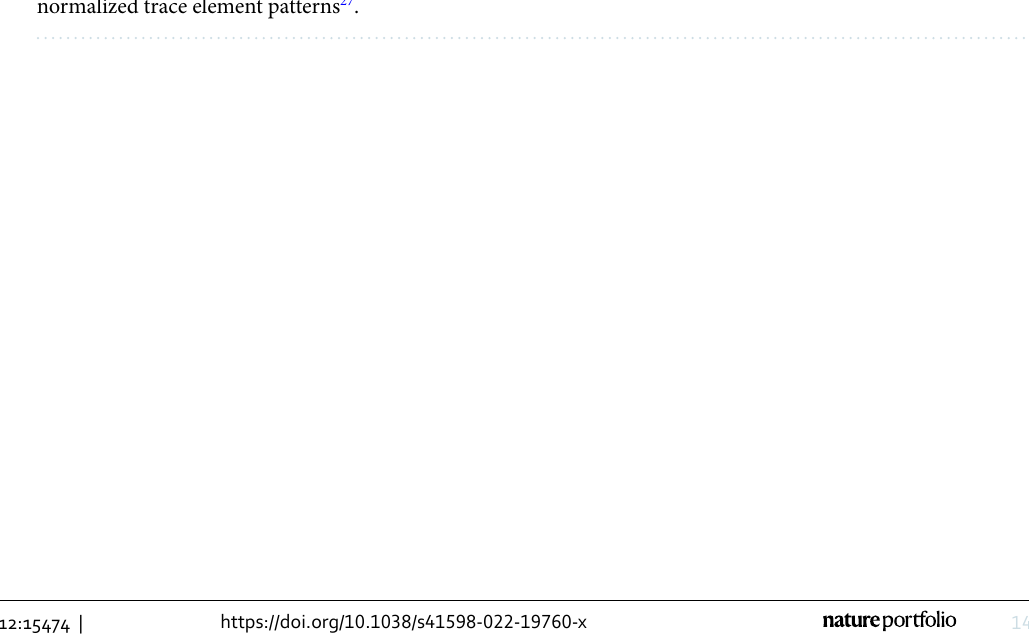
Figure 10. Whole-rock chemistry of Akab El-Negum mafic rocks. ( a ) Whole-rock chondrite-normalized REE patterns 27 compared with Fe–Ti rich gabbro in Damiao complex in the North China 28 , and ( b ) Primitive mantle- normalized trace element patterns 27